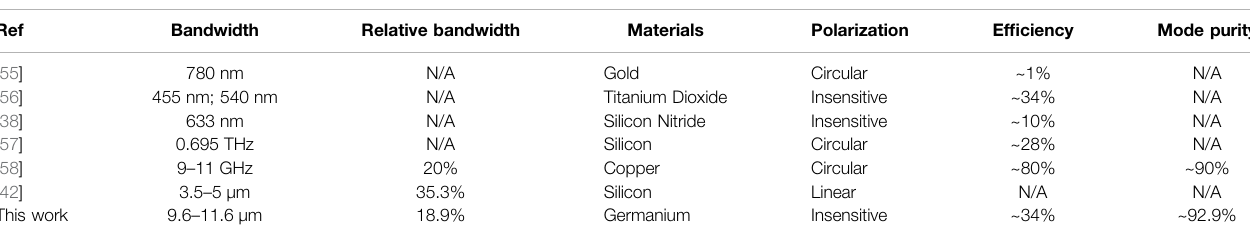
TABLE 1 | Comparison between this work and previously reported fl at FOV generators.